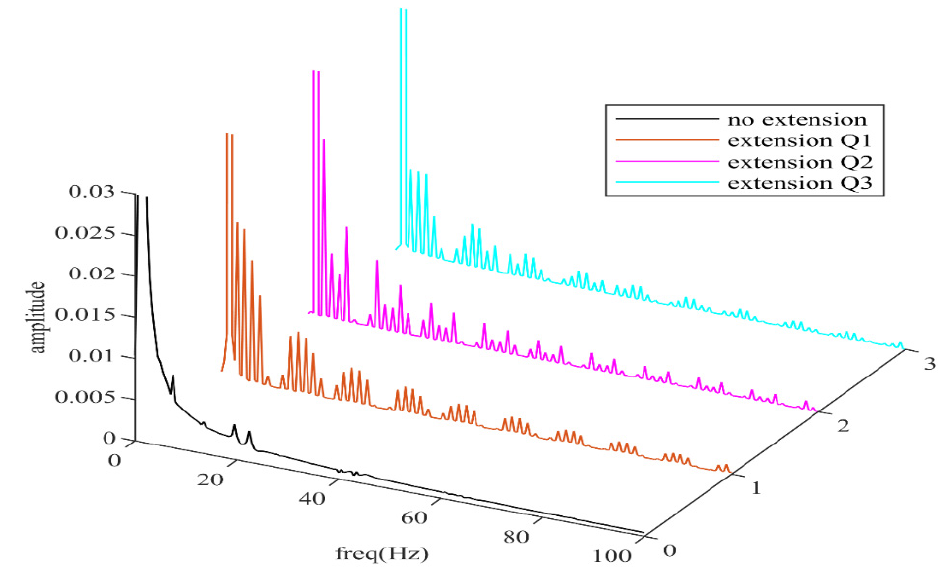
Figure 18. FFT of the current waveforms at 90 rpm using different extension schemes.